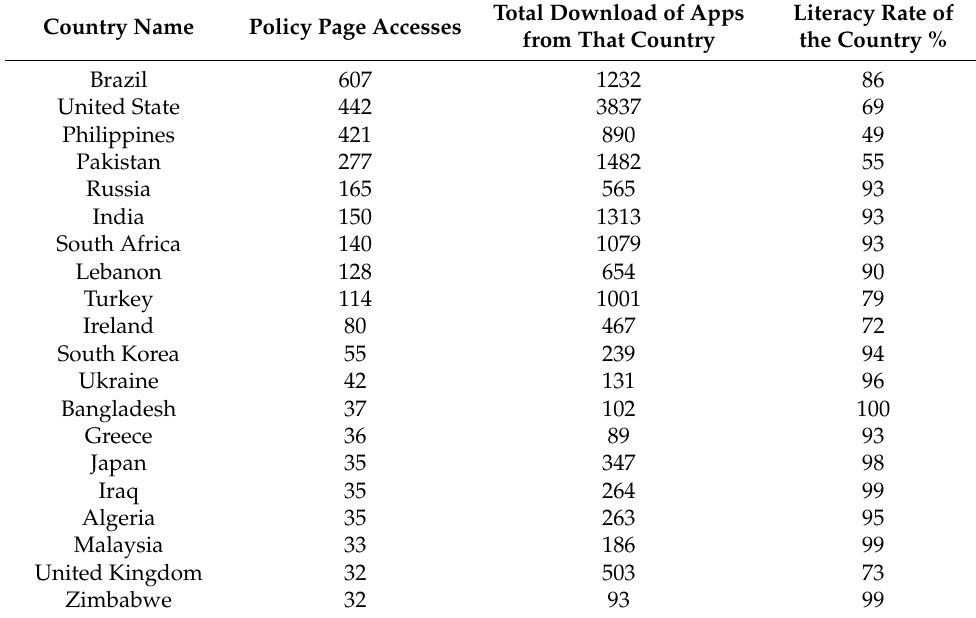
Table 1. Top countries with apps downloads with literacy rate and privacy policy